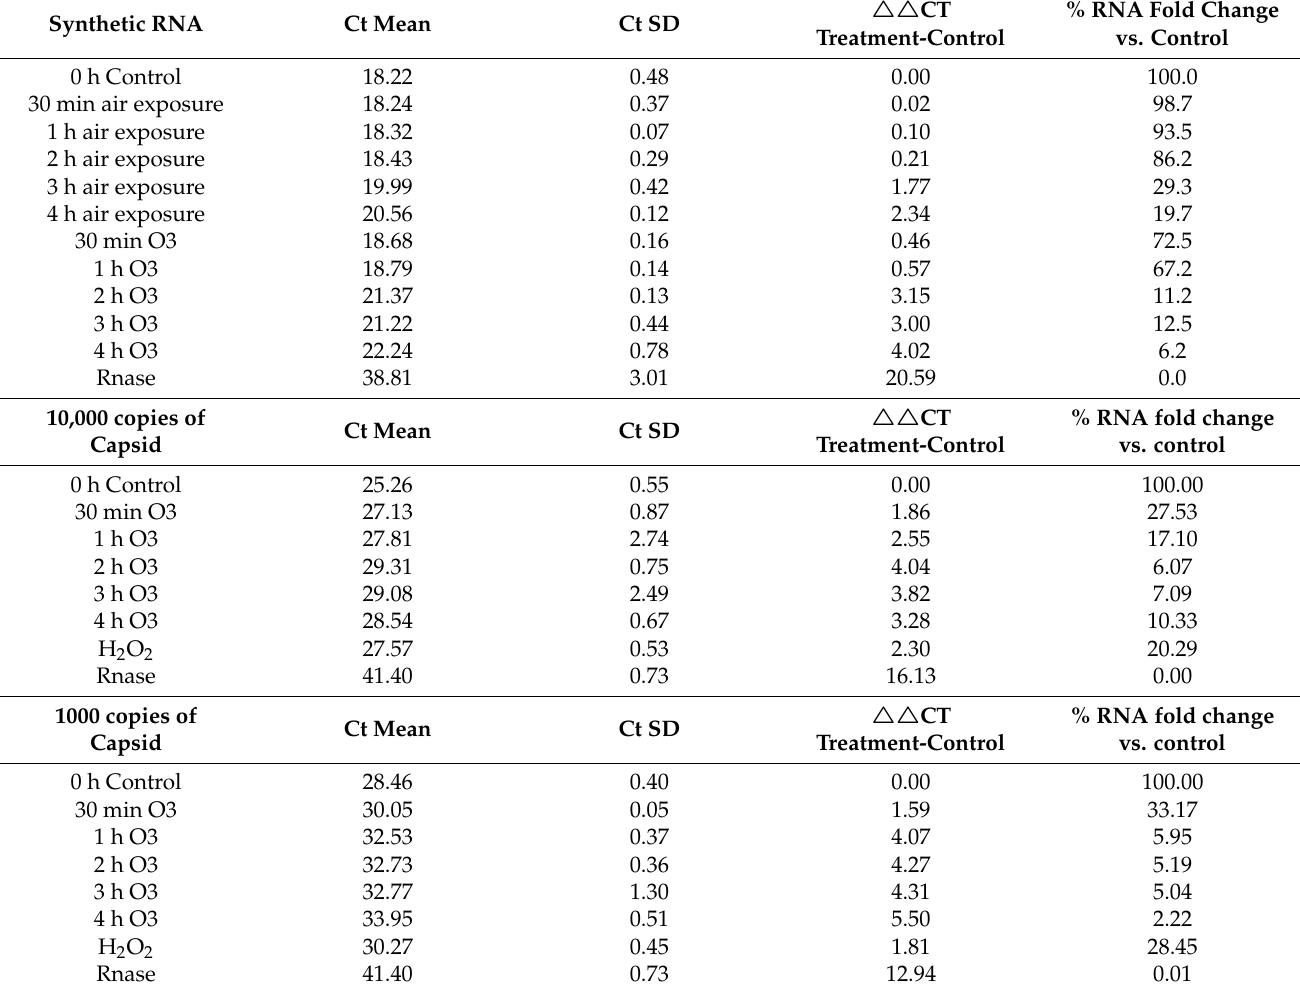
Table 2. RNA Data. Ct values and % RNA fold change across different time